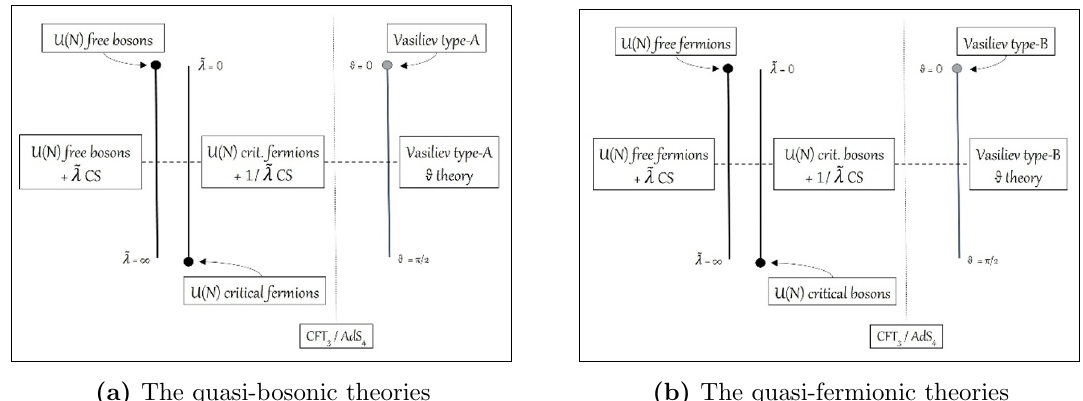
Figure 1. The bosonisation dualities have two branches that relate two pairs of CS-matter theories: (a) The quasi-bosonic theories : the starting point is the singlet sector of the free U( N ) bosonic theory (‘U( N ) free bosons’). We can then turn on the coupling ~ (cid:21) (a monotonic function of the ’t Hooft coupling (cid:21) ; see section 3), and on taking it to in(cid:12)nity (the strong coupling limit (cid:21) ! 1), the correlators of the CS-bosonic theories go over to that of the critical fermionic (Gross-Neveu) (cid:12)xed point, which is the end-point of the line. The bosonisation duality relates this (critical) fermionic theory coupled to CS theory with strength 1/~ (cid:21) to the free bosonic theory coupled to CS theory with strength ~ (cid:21) . The corresponding bulk duals are the type-A (cid:18) theories (parametrised by (cid:18) 2 [0 ; (cid:25)= 2]). (b) The quasi-fermionic theories : starting from the free fermionic theory, we can turn on the CS coupling as in the previous case, and sending it to in(cid:12)nity gives the critical bosonic (Wilson-Fischer) theory. The relevant bosonisation duality relates free fermionic CS theories to critical bosonic theories coupled to CS. The bulk duals are given by the type-B (cid:18) theories. In this paper, we will be interested in this family of